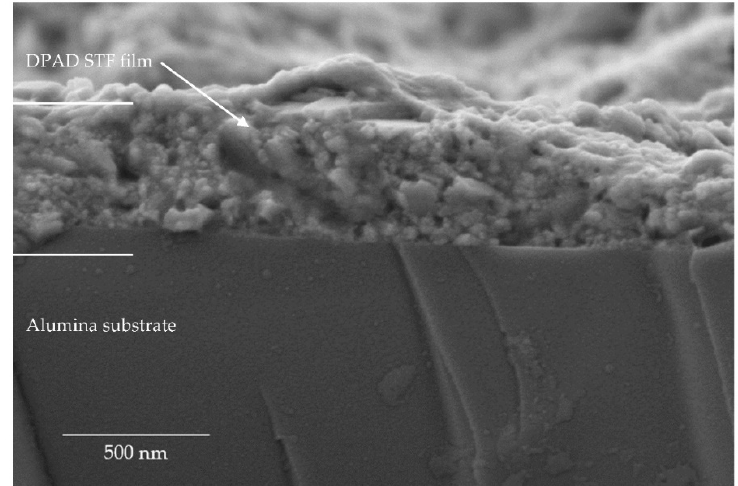
Figure 4. SEM fracture pattern of STF35 on an Al 2 O 3 substrate.